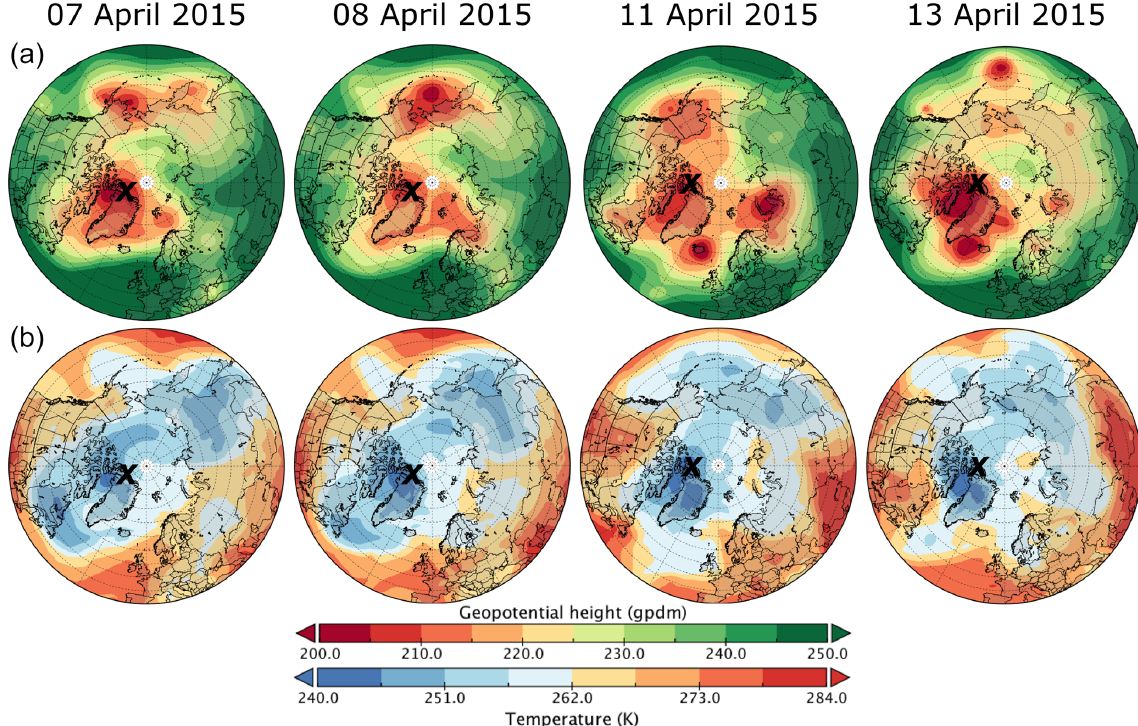
Figure 2. Weather charts for the NETCARE spring campaign in April 2015 showing the 750hPa geopotential height (a) and tempera- ture (b) evolution over the duration of the campaign. The stations Alert or Eureka are marked with a black cross for the maps from 7 to 8 April and 11 to 13 April,